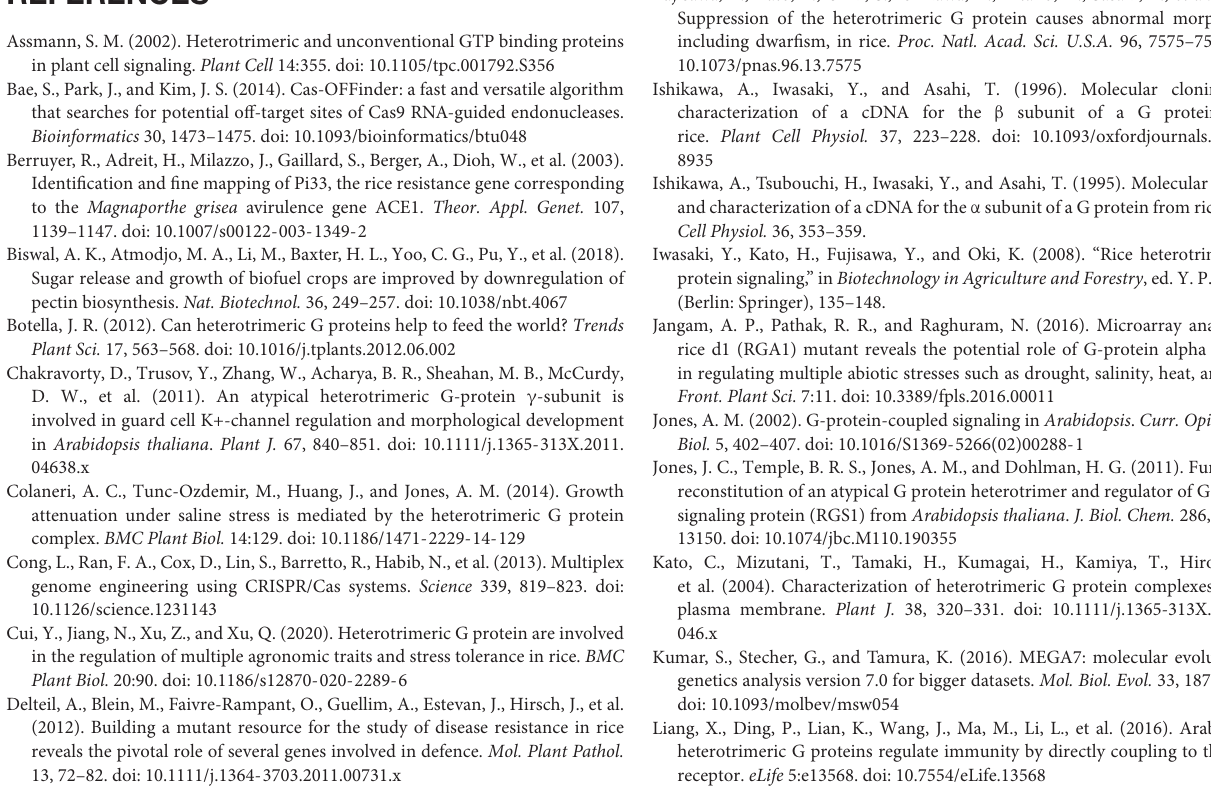
∗ p < 0.05, ∗∗ p < 0.01. Significant differences between WT-NIP and Osxlg mutants were determined as calculated by statistical analysis using Statistica 5.0 with one-way ANOVA followed by Tukey’s multiple comparison test. Supplementary Figure 2 | Analysis of plant height of Osxlg mutants at different time points. Measurement of plant height (A–C) of Osxlg-KO mutants throughout the growth of the period from weeks 4 to 12 in comparison with the controls. Data are presented as box and whiskers plots showing the mean as “ + ” inside the boxes and the error bars represent 95% confidence intervals. For (A) n = 10 (TP309, NIP, Osxlg1 ), n = 12 ( Osxlg-2 and Osxlg-4 ); For (B) n = 10 (TP309, NIP), n = 12 ( Osxlg1-2, 4-2 and Osxlg 2-5, 4-2 ); For (C) n = 10 (TP309, NIP), n = 6 ( Osxlg1,2,4-3; Osxlg1,2,4-5; Osxlg1,2,4-6 ). Significance p- values are expressed as ∗ p < 0.05, ∗∗ p < 0.01 by comparing WT-NIP with Osxlg mutants as calculated by statistical analysis using Statistica 5.0 with one-way ANOVA followed by Tukey’s multiple comparison test. Supplementary Figure 3 | Analysis of plant tiller growth and number of Osxlg mutants at different time points. Measurement of tiller numbers (A–C) of Osxlg-KO mutants throughout the growth of the period from weeks 4 to 12 in comparison with the controls. Data are presented as box and whiskers plots showing the mean as “ + ” inside the boxes and the error bars represent 95% confidence intervals. For (A) n = 10 (TP309, NIP, Osxlg1 ), n = 12 ( Osxlg-2 and Osxlg-4 ); For (B) n = 10 (TP309, NIP), n = 12 ( Osxlg1-2, 4-2 and Osxlg 2-5, 4-2 ); For (C) n = 10 (TP309, NIP), n = 6 ( Osxlg1,2,4-3; Osxlg1,2,4-5; Osxlg1,2,4-6 ). p -Values are expressed as ∗ p < 0.05, ∗∗ p < 0.01. Significance differences between WT-NIP and Osxlg mutants were determined by statistical analysis using Statistica 5.0 with one-way ANOVA followed by Tukey’s multiple comparison test. Supplementary Figure 4 | Tissue-specific expression of XLGs in rice. Rice (A) OsXLG1 ( LOC_Os06g02130 ), (B) OsXLG2 ( LOC_Os11g10050 ), and (C) OsXLG4 ( LOC_Os12g40190 ) expression in different tissues. The expression data were extracted from the meta-transcriptome data available at http://expression.ic4r.org/ (Xia et al.,